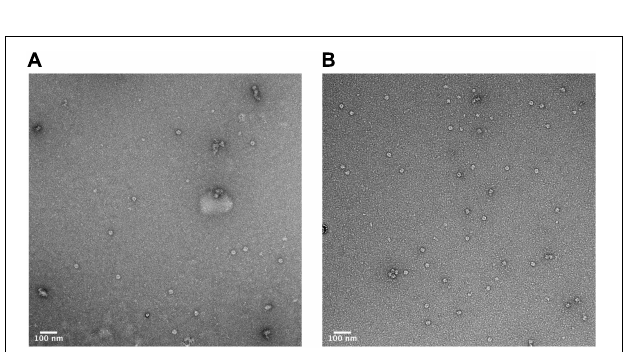
FIGURE 4 | Characterization of HBc VLPs obtained from assembly and crude purification using transmission electron microscopy (TEM). (A) HBc VLPs obtained from incubation in assembly buffer in the absence of CIP (untreated assembly) (B) HBc VLPs obtained from incubation in assembly buffer supplemented with CIP (CIP-treated assembly). Scale-bar size: 100